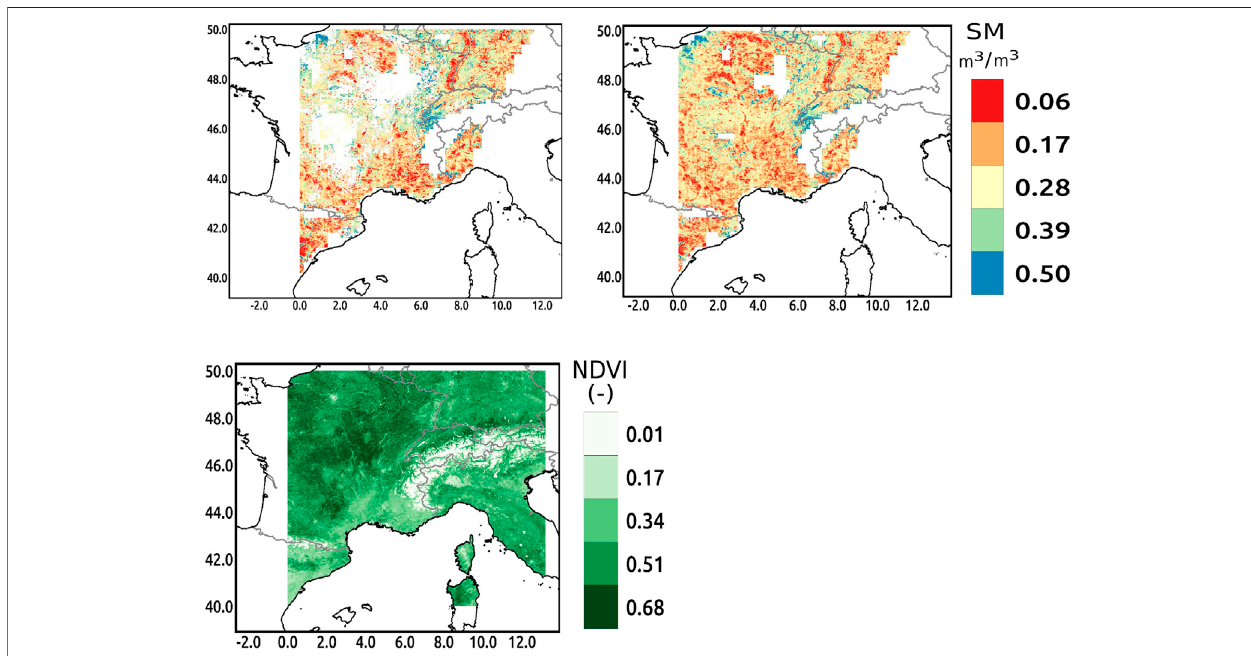
FIGURE 4 | Images over the MODIS tile H18V04 of 1 km resolution disaggregated SM derived from DISPATCH classic (left top) and DISPATCH veg – ext (right top) and NDVI (left bottom) on DOY 112, 2018.